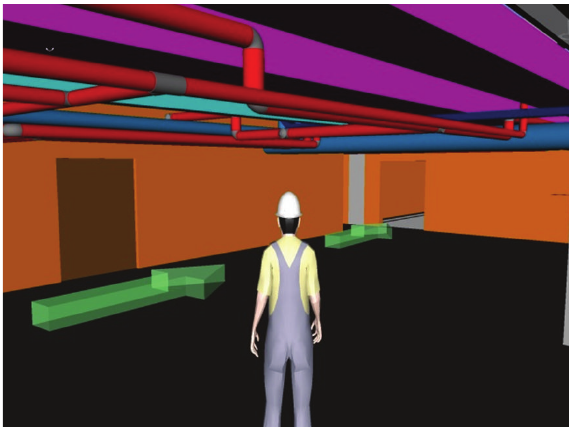
Figure 10: Third person view of